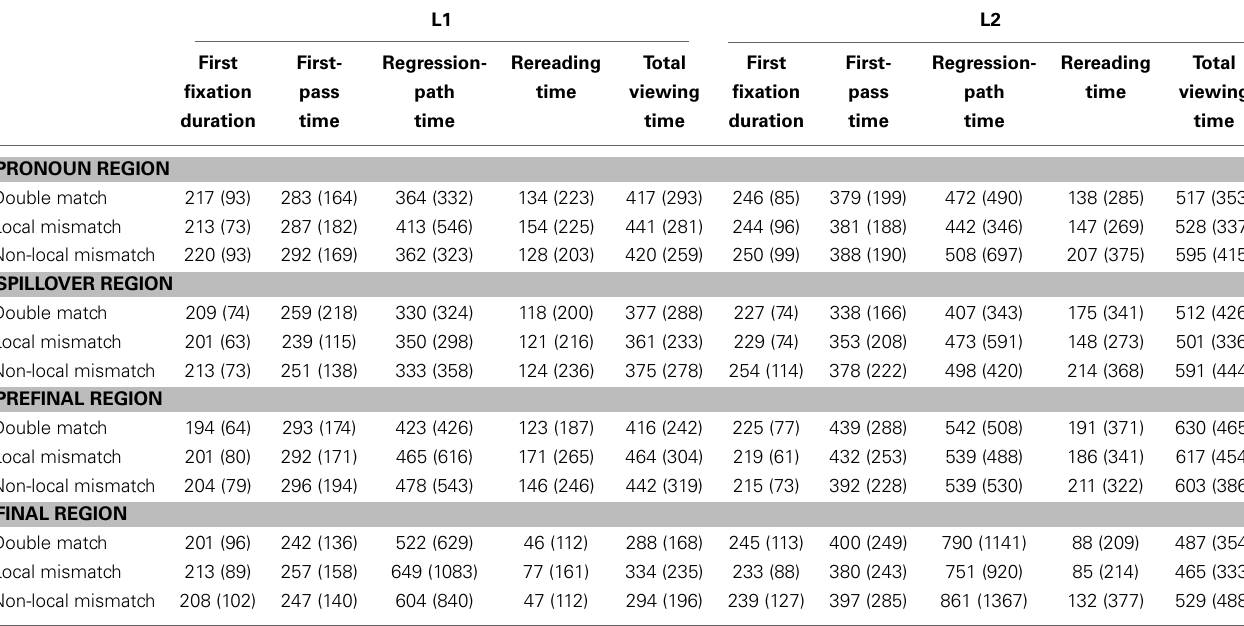
Table 4 | Means (standard deviations in parentheses) for five eye-movement measures at four areas of interest in Experiment 3, for each participant